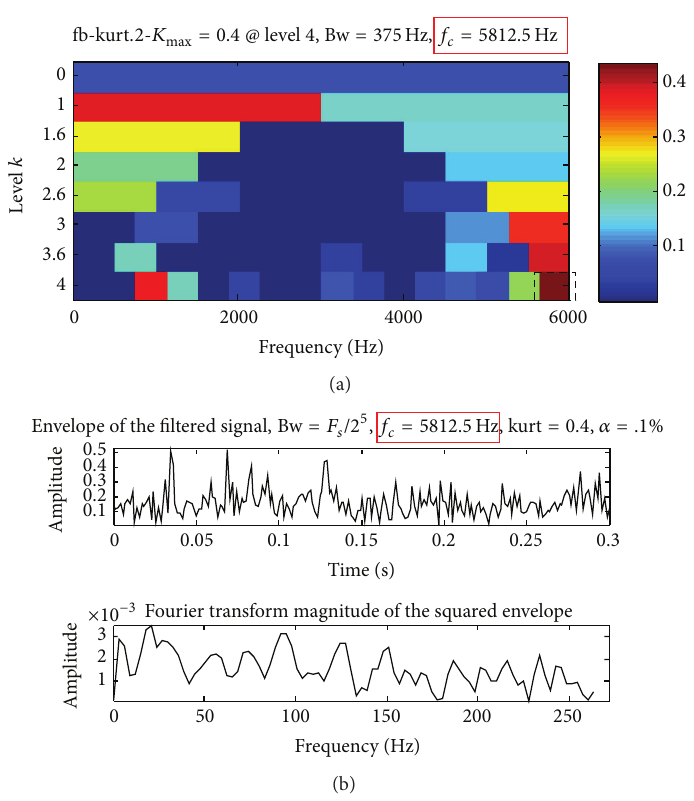
Figure 7: Analyzed results of the simulated signal shown in Figure 2(b) by the fast Kurtogram: (a) Kurtogram of the simulated signal; (b) envelope of the filtered signal and corresponding demodulation